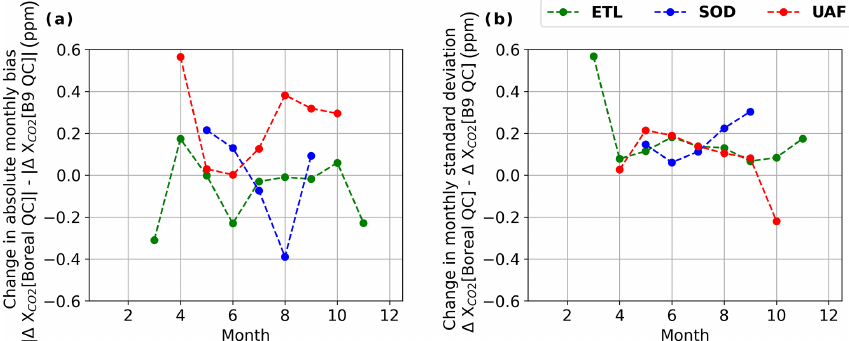
Figure 17. Differences between average monthly biases (a) or standard deviation in monthly biases (b) when comparing boreal QC to B9 QC. Note that Fig. 10 shows typical average monthly bias ranges from − 1 to 1parts per million